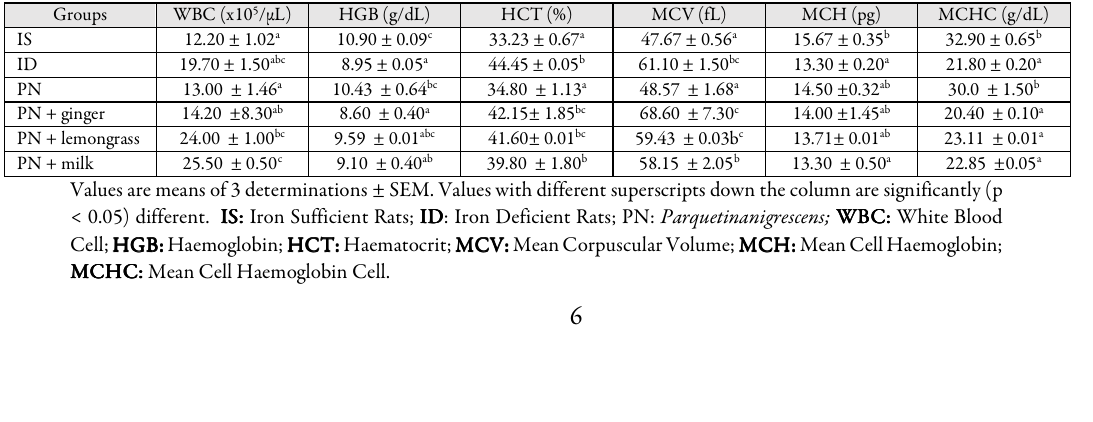
Table 4. Haematological indices of rats following oral administration of 1000 mg/kg body weight infused extracts of Parquetina nigrescens leaf with additives for 28 days Groups